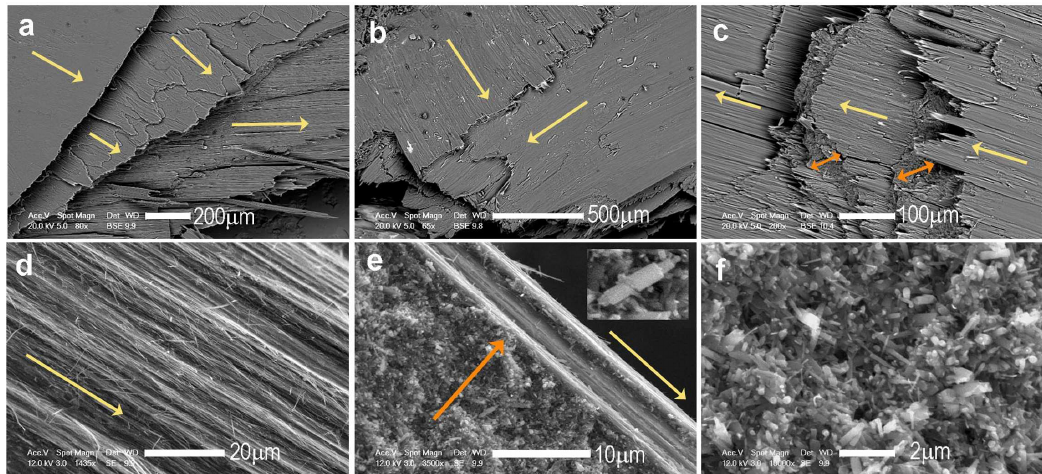
Figure 7. Back-scattered electron scanning electron microscope (BSE/SEM) images of slickenfibre veins and faults formed by fibrous serpentines (chrysotile and polygonal serpentine). ( a , b ) The yellow arrows highlight the sharp changes in fibre orientation in overlapping veins, probably reflecting local changes in shear direction. ( c ) Intercalation of fibrous veins with strongly oriented fibres (yellow arrows, mostly chrysotile) and randomly oriented fibres (orange arrows, mostly polygonal serpentine). ( d ) Detail of a slickenfibre surface, showing long fibres of chrysotile with preferred orientation parallel to shear direction. ( e , f ) Details of randomly oriented veins, characterised by the predominance of short fibres of polygonal serpentine; the inset in Figure 6e shows the typical habit of polygonal serpentine parallel to fibre axis (e.g., [28]).